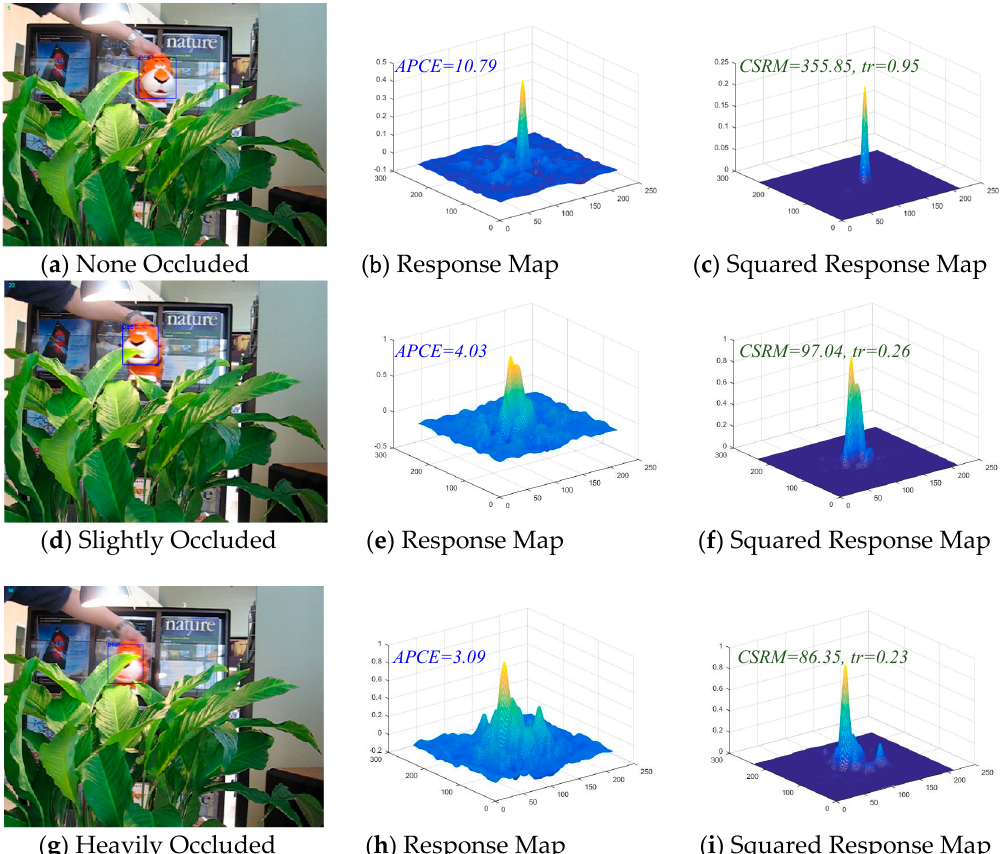
Figure 4. The Confidence of the Squared Response Map (CSRM) in the proposed MACF comparing with the Average Peak-to-Correlation Energy (APCE) of the response map. The example frames are from the sequence “Tiger1” on OTB-100 benchmark. The higher value of the CSMR, the more confident the response map is. The value of parameter tr determine the adaptive learning rate which compute by Equation (20). From the figure, the gap of CSMR is larger than APCE between the slightly occluded, heavily occluded and none occluded target.